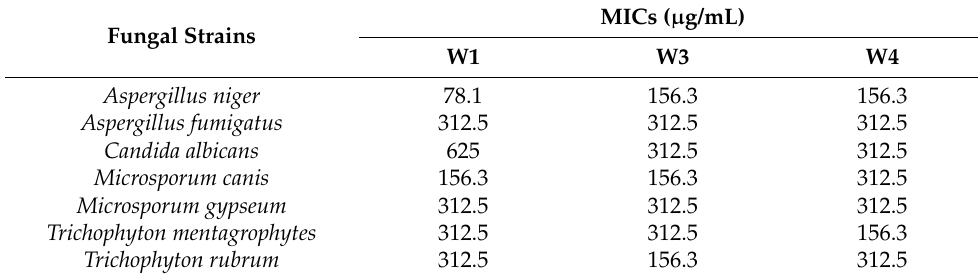
Table 13. Minimum inhibitory concentrations (MICs) of wintergreen essential oil against tested fungal strains a